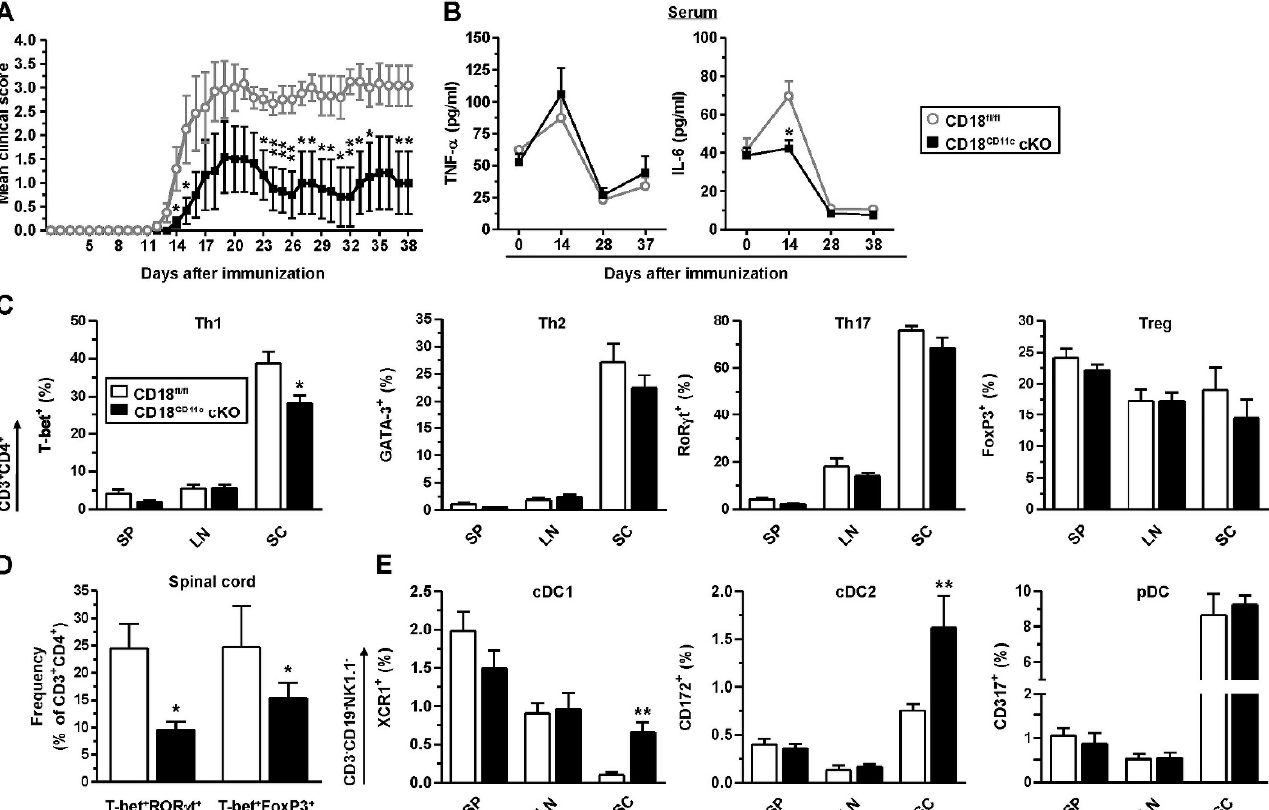
Figure 6. CD18 CD11c cKO mice display an attenuated course of EAE, associated with lowered frequencies of T-bet-expressing T helper cells in spinal cord. Mice were immunized on d 0 with MOG 35–55 peptide in complete Freund’s adjuvant via the tail vein. Pertussis toxin was applied on d 0 and d 2. Mice were observed on a daily base for 38 d, followed by ex vivo analysis. ( A ) Clinical score of EAE symptoms (scoring details given in Section 2.13). Data denote the mean ± SEM of 7 mice per group, representative of 2 experiments. ( B ) Blood was retrieved throughout the observation period for cytokine detection (mean MFI ± SEM, n = 7 mice/group). ( C ) Frequencies of transcription factor- expressing CD3 + CD4 + T cells in spleen (SP), inguinal/paraaortic lymph node (LN), and spinal cord (SC) (mean ± SEM, n = 3–7 mice/group) The gating strategy is depicted in Figure S8. ( D ) Frequencies of T-bet + ROR γ T + and T-bet + Foxp3 + double-positive CD3 + CD4 + T cells in spinal cord (mean MFI ± SEM, n = 3–4 mice/group). ( E ) Frequencies of DC populations in the various organs (mean ± SEM, n = 3–7 mice/group). The gating strategy is shown in Figure S9. ( A – D ) Statistical differences versus * CD18 fl/fl at corresponding conditions are indicated (one-way ANOVA, Tukey test). * p < 0.05, ** p < 0.01. Altogether, our results indicate that the β 2 integrin knockdown in DCs resulted in stronger stimulation-induced activation, which was most pronounced on the cytokine level, due to attenuated SOCS expression. However, at the same time, these stimulated DCs were characterized by impaired T cell stimulatory activity, resulting in attenuated autoinflammatory reactions.